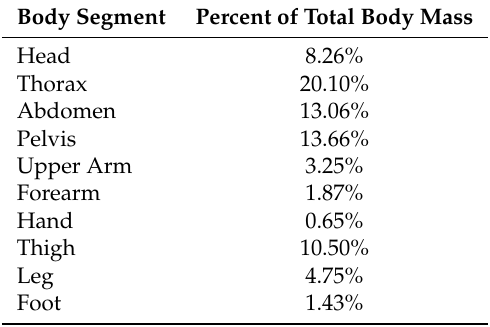
Table 1. Distribution of body mass for males [41].